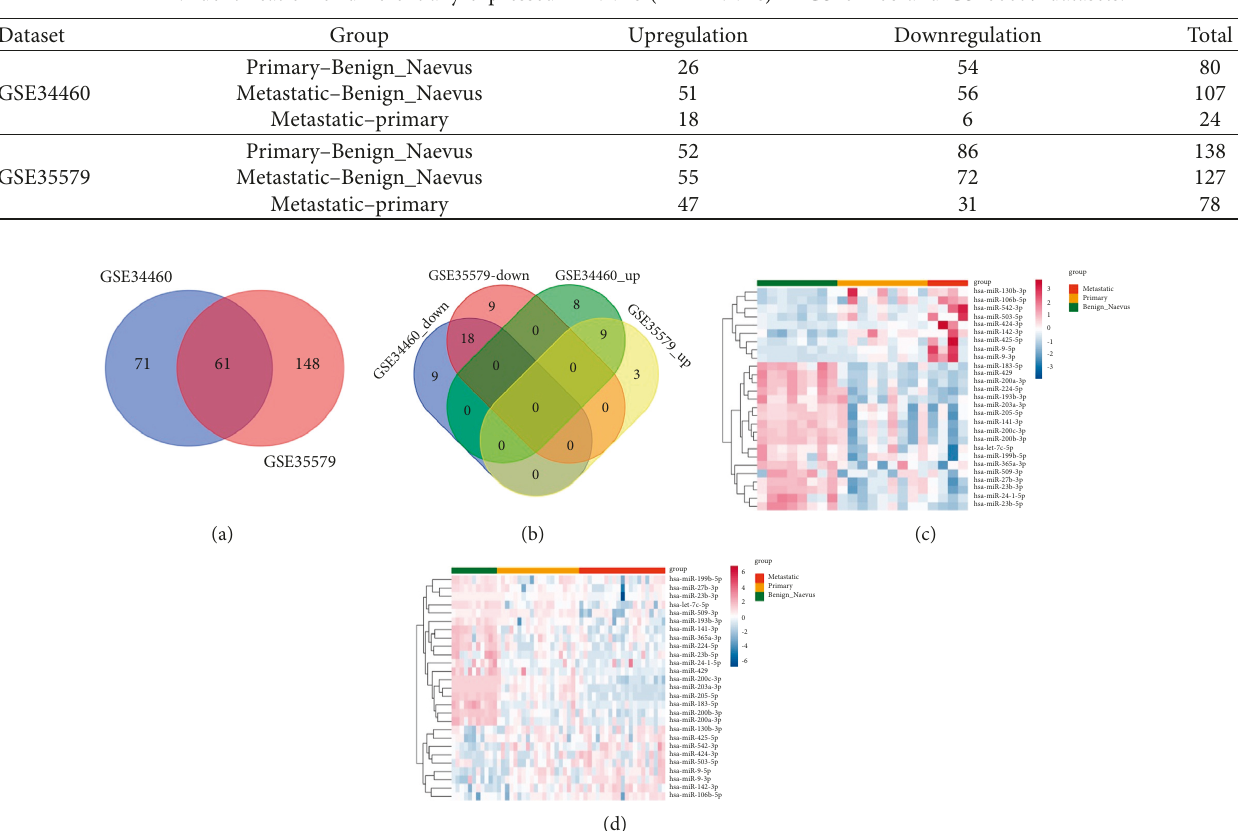
Figure 2: Identification of differentially expressed miRNAs (DEmiRNAs) related to melanoma progression. (a) The common DEmiRNAs screened in GSE34460 and GSE35579 datasets. (b) The miRNAs related to melanoma progression. The heatmaps of the miRNAs related to melanoma progression in GSE34460 (c) and GSE35579 (d) datasets,